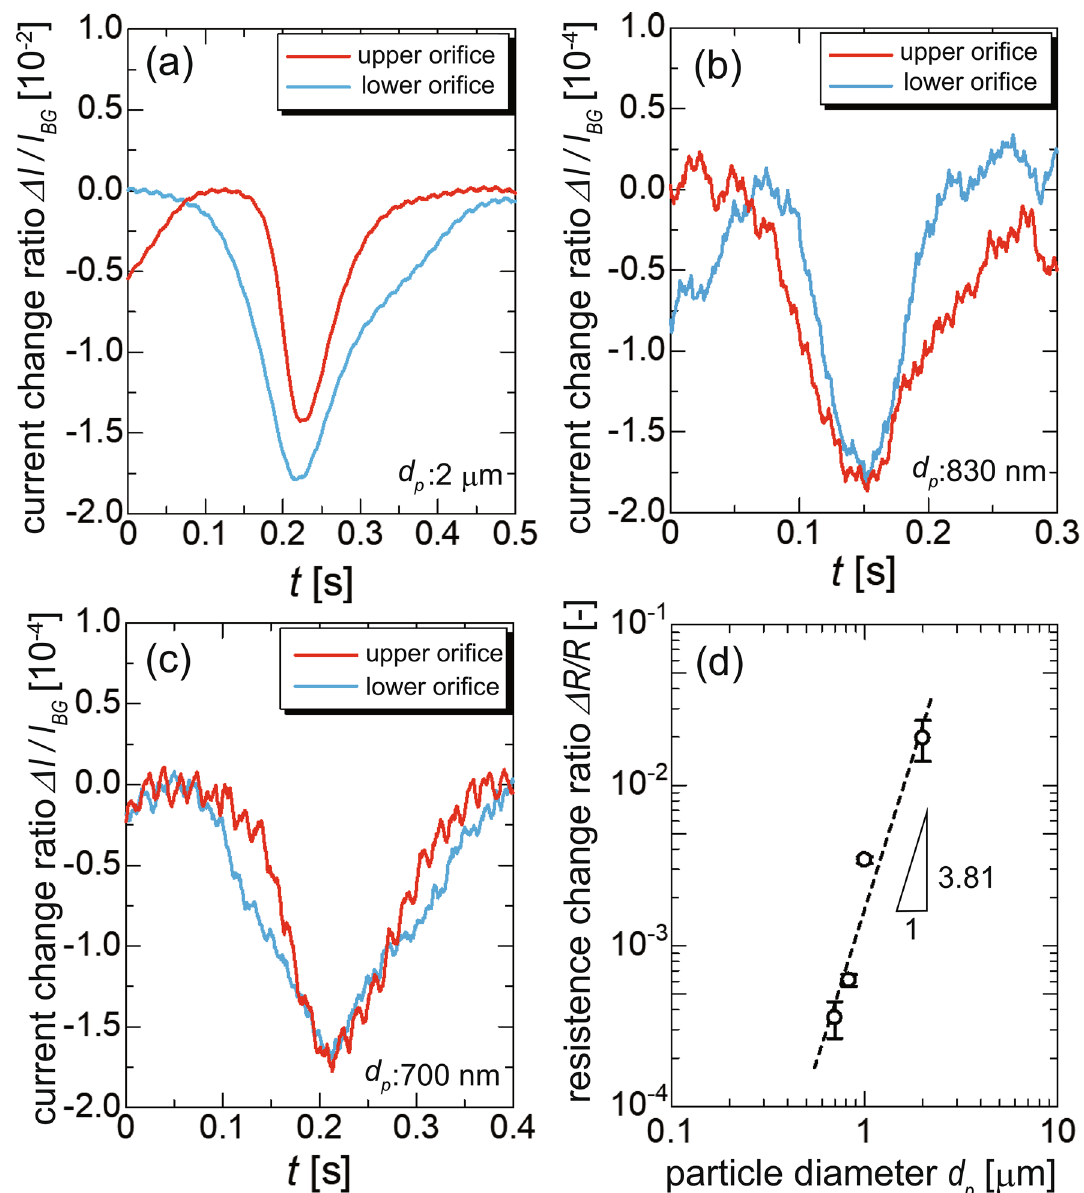
Figure 5. Results of resistive-pulse analysis using the optical vortex for particles with diameters of ( a ) 2 µ m, ( b ) 830 nm, and ( c ) 700 nm. The applied voltages for the measurement of 2- µ m, 830-nm, and 700-nm particles are 0.3, 0.5, and 0.6 V, respectively. The waveforms are the synchronized averages of 70 pulses. The vertical axis denotes the amplitude of the resistive pulse standardized by the background current. ( d ) Relationship between the particle volume and the amplitude of the resistive pulse, which is averaged over the upper and lower orifices. The slope of the fitted curve of 3.81 is not far from the prediction based on the exclusive volume of the particle (a slope of 3), equally indicating the existence of the other factors affecting the resistive-pulse amplitude. The error bars denote the standard deviation ( n ≧ 3 ), where n is a number of the independently analyzed particle, not the number of averaging N